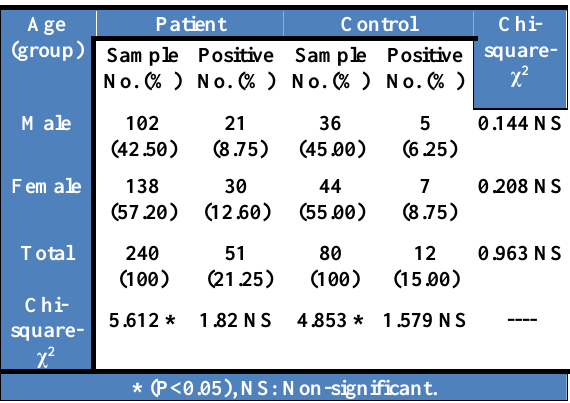
Table, 3: Distribution of toxin A and/or B according to